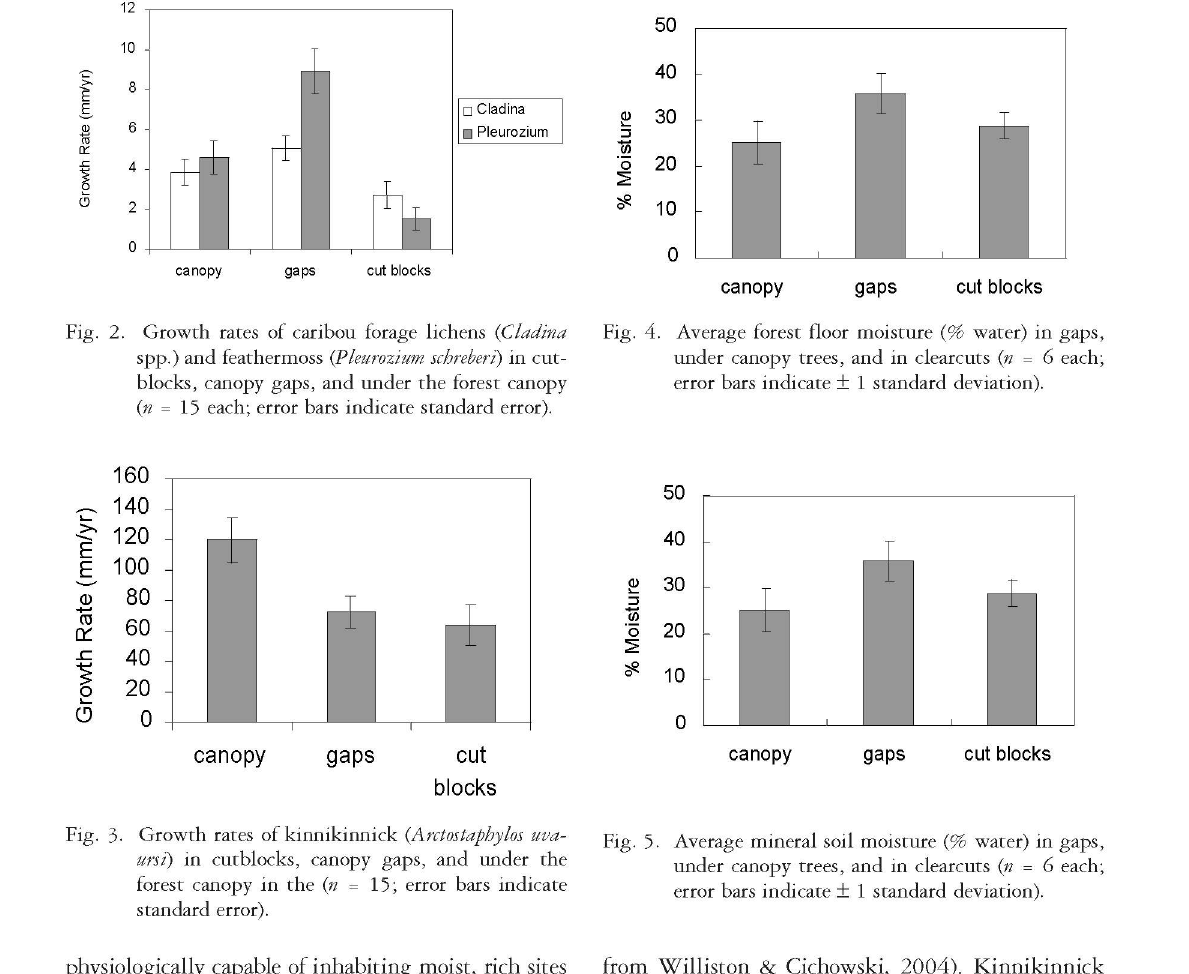
Fig. 3. Growth rates of kinnikinnick (Arctostaphylos uva- ursi) in cutblocks, canopy gaps, and under the forest canopy in the (n = 15; error bars indicate standard error).